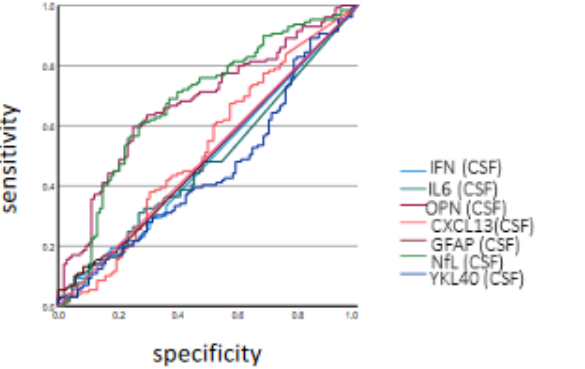
Figure 2. ROC analysis found statistically significant AUC for OPN and NFL-L. AUC was 0.68 for both OPN and NF-L (CI 95% 0.6–0.7, p < 0.005 for both biomarkers).